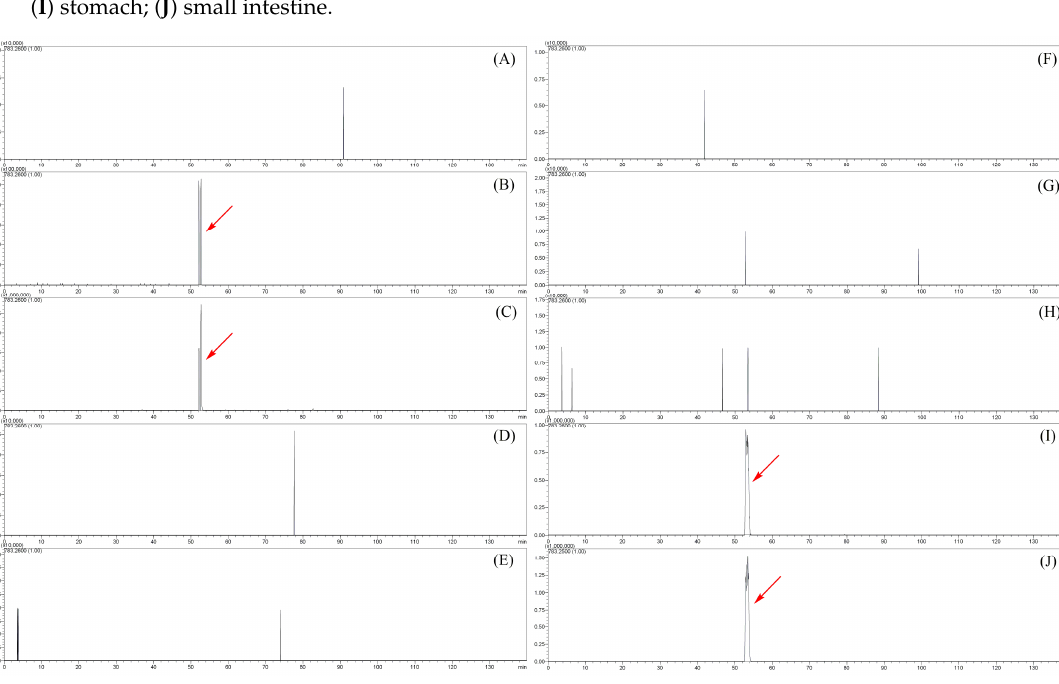
Figure 6. The EIC at m/z 783.2600 of angoroside C in different biological samples. ( A ) plasma; ( B ) urine; ( C ) feces; ( D ) heart; ( E ) liver; ( F ) spleen; ( G ) lung; ( H ) kidney; ( I ) stomach; ( J ) small intestine.